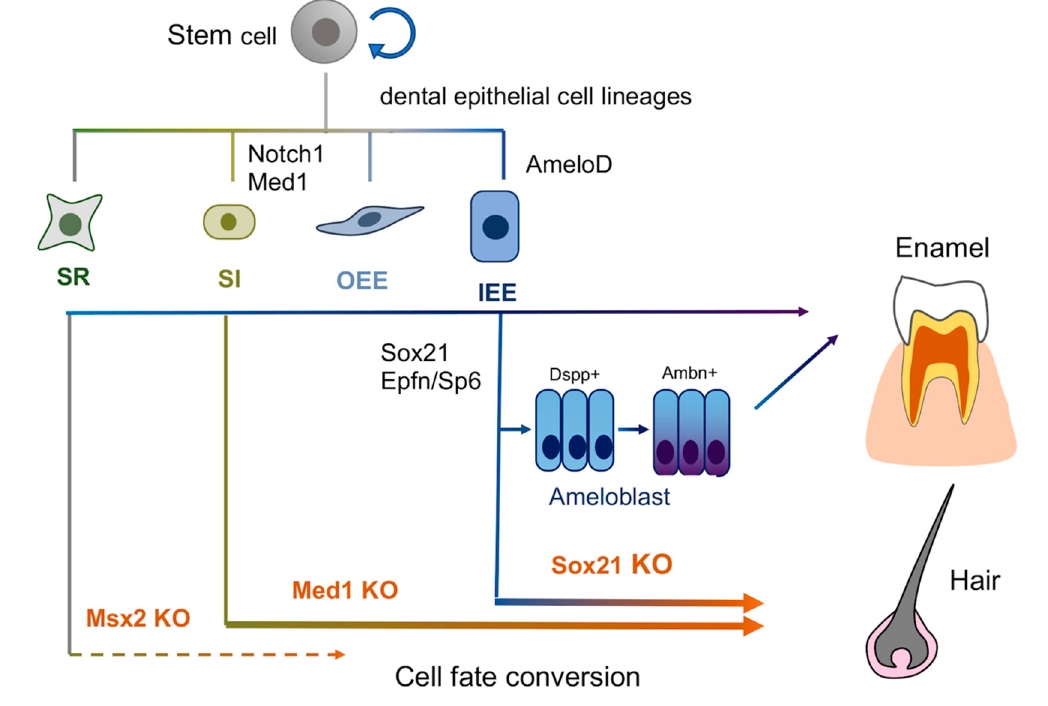
Figure 2. A proposed model in which Sox21, Med1 and Msx2 knockout (KO) mice alters dental epithelial cell fate to skin epithelia through IEE/ameloblast, SI and SR lineage, respectively.